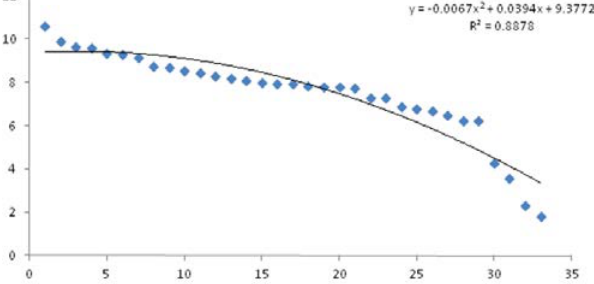
Fig. 8. Relative abundance of aquatic resident birds. Data on X axis indicates species and on y axis individuals of corresponding species converted to log